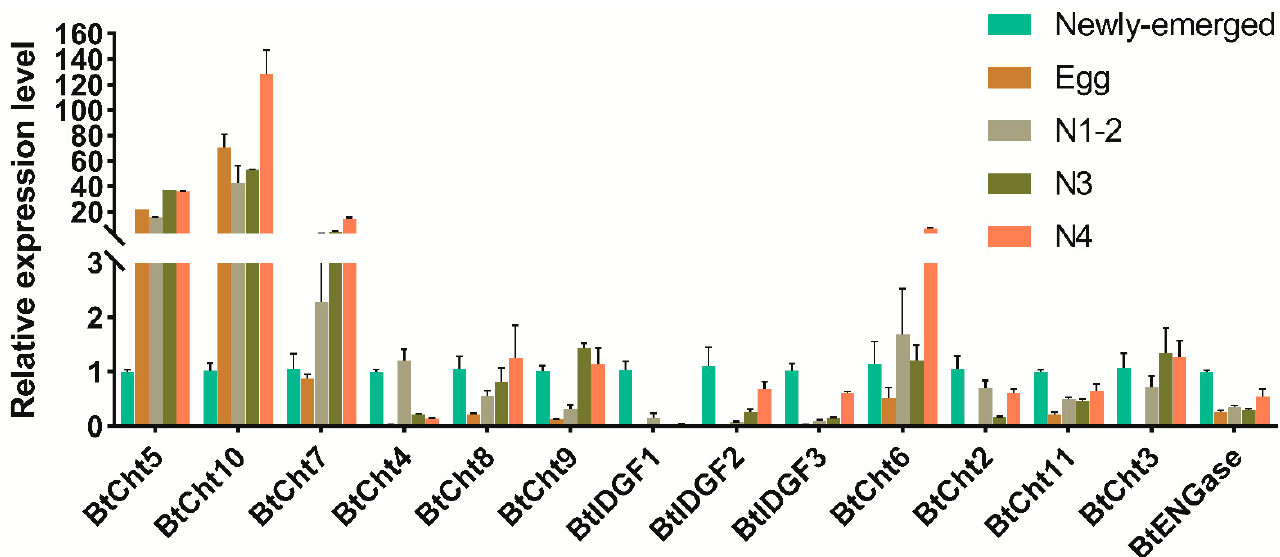
Figure 5. Expression patterns of 14 chitinase-like genes in different development stages of B. tabaci by quantitative real-time PCR (qRT-PCR). Total RNA was extracted from samples including mixture of first and second instar nymphs (N1-2), third instar nymphs (N3), forth instar nymphs (N4) and newly emerged adults. The B. tabaci elongation factor 1 alpha (EF1- α ) and 60S ribosomal protein L29 (RPL29) were used as an internal control. The real-time qPCR results were analyzed by the △△ Ct (Cycle threshold) method. Three biological replicates were performed for each gene based on independent RNA sample preparations. Cht, chitinase; ENGase, endo- β -N-acetylglucosaminidase; IDGF, imaginal disk growth factor.